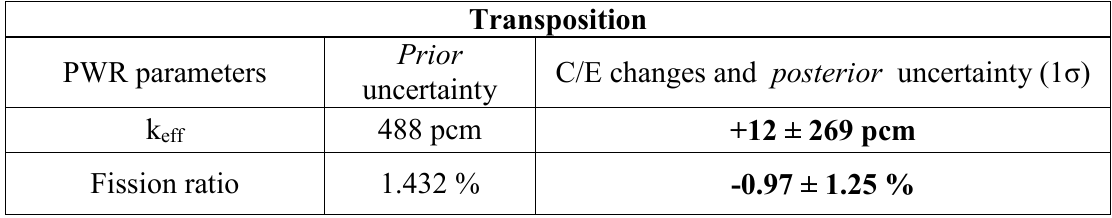
results to PWR case : uncertainties and bias gain eff